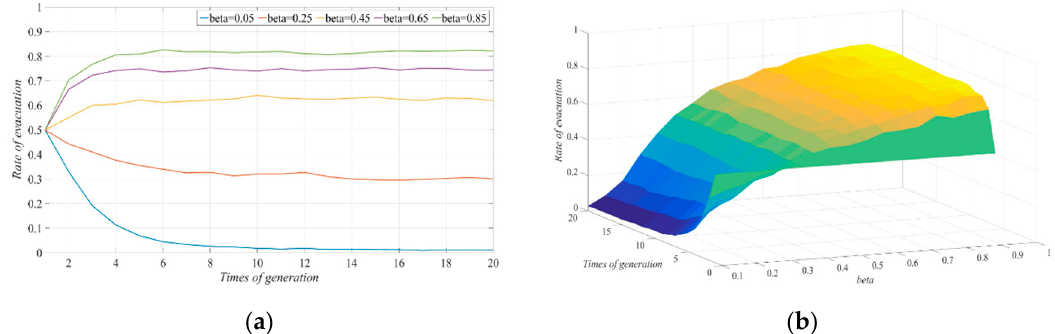
Figure 2. E ff ect of changes in β on the evolution of evacuation systems: ( a ) two-dimension; ( b )